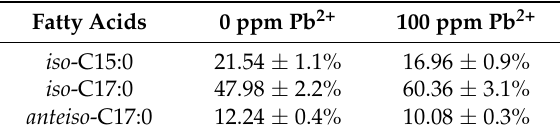
Table 1. Major fatty acid methyl ester profiles of T. thermophilus grown in 0 and 100 ppm Pb 2+ . Values are the mean of three experiments ± standard deviation (SD).